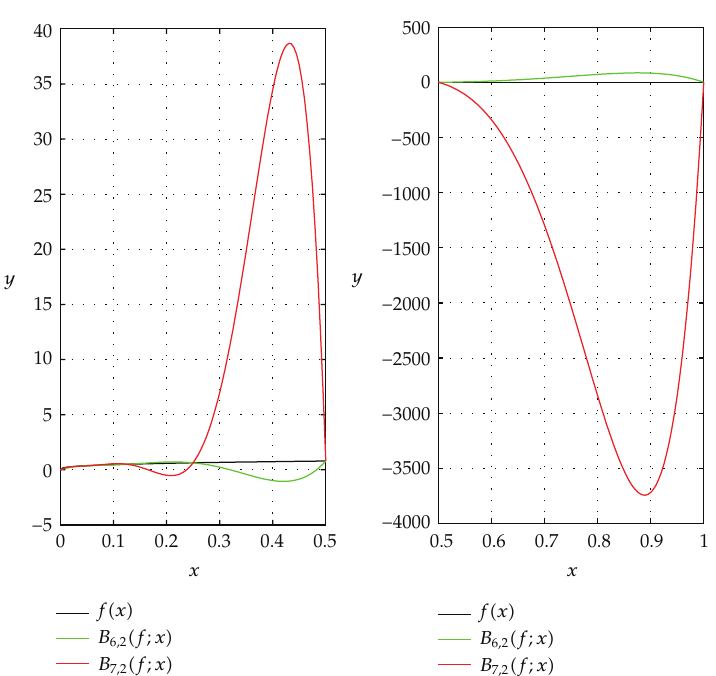
Figure 2: Graphs of y (cid:6) f (cid:2) x (cid:3) and y (cid:6) B n, 2 (cid:2) f ; x (cid:3) , n (cid:6) 6 ,